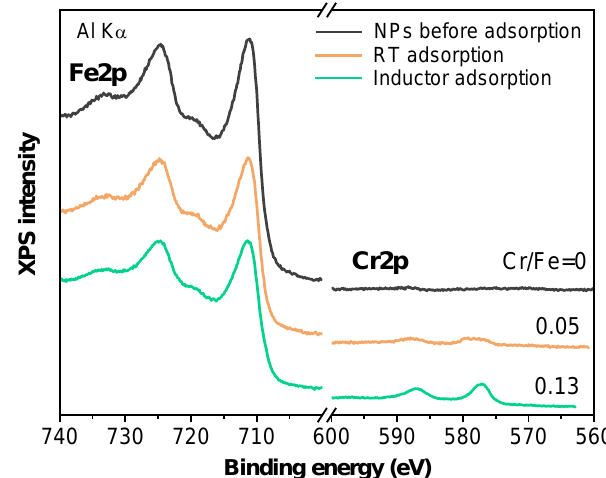
Figure 7. Fe2p and Cr2p XPS spectra taken with Al-K α radiation corresponding to NPs before adsorption, and room temperature and inductor processed samples. Relative percentage of Cr / Fe atomic concentration determined by XPS analysis is shown.